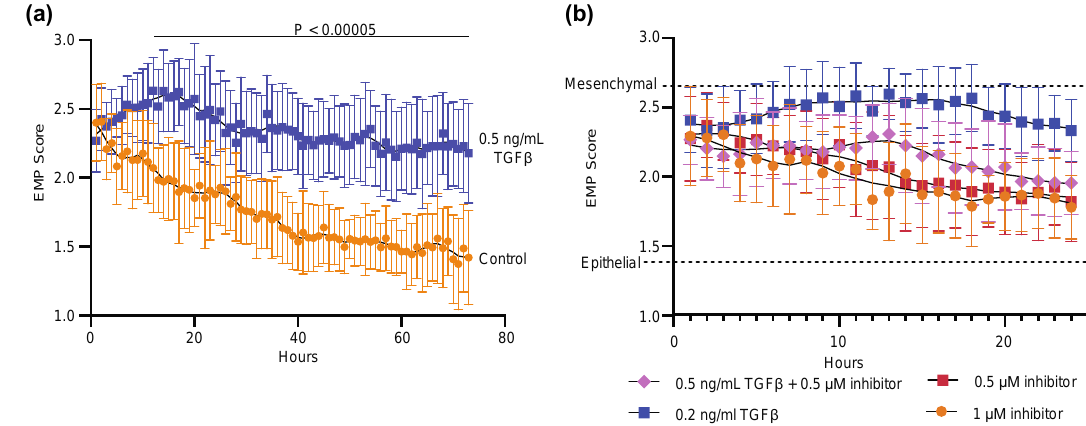
Figure 3. An “EMP score” generated from four morphological features chosen from correlation matrixes (Figure 2) distinguishes between epithelial and mesenchymal NMuMG cells. The treatments were initiated at time 0 at the start of time-lapse imaging using a digital holographic microscope. ( a ) Images of cells treated with 0.5 mg / mL TGF β or control were captured every hour for 72 h. The control and treated conditions in each time-point were compared using the two-sample equal variance t -test. At all time-points after 11 hours (horizontal bar) p values generated from this comparison were less than 0.00005. ( b ) Images of cells treated with indicated conditions were captured every hour for 24 h. inhibitor, TGF β RI. Data from 15 images over 3 experiments and bars show ±SD.